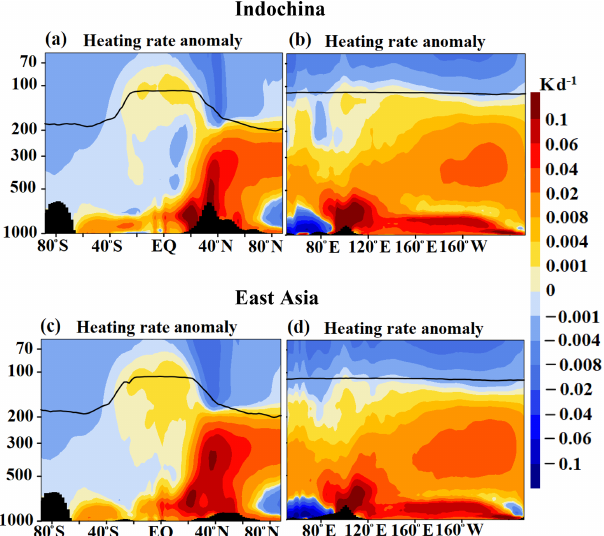
Figure 8. Vertical section of heating rate anomalies (Kd − 1 ) for the spring season 2013 from ECHAM6–HAMMOZ simulations (BMaeroon − BMaerooff); (a) latitude–pressure section averaged for 91–107 ◦ E and (b) longitude–pressure section averaged for 18– 24 ◦ N. (c) Same as (a) but averaged for 108–123 ◦ E. (d) Same as (b) but averaged for 22–27 ◦ N. The black vertical bars show the topog- raphy and the black line indicates the tropopause.